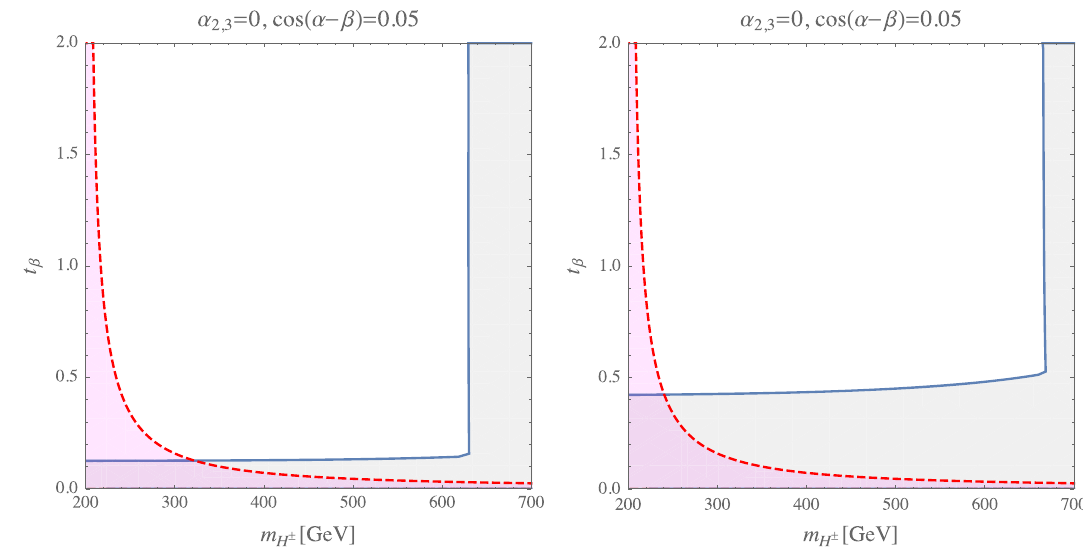
Fig. 5 Parameter space for m H ± and tan β excluded by B → X s γ within 2 σ (red) and unitarity bounds (gray) with y u 160 GeV (left panel) and m A = m h